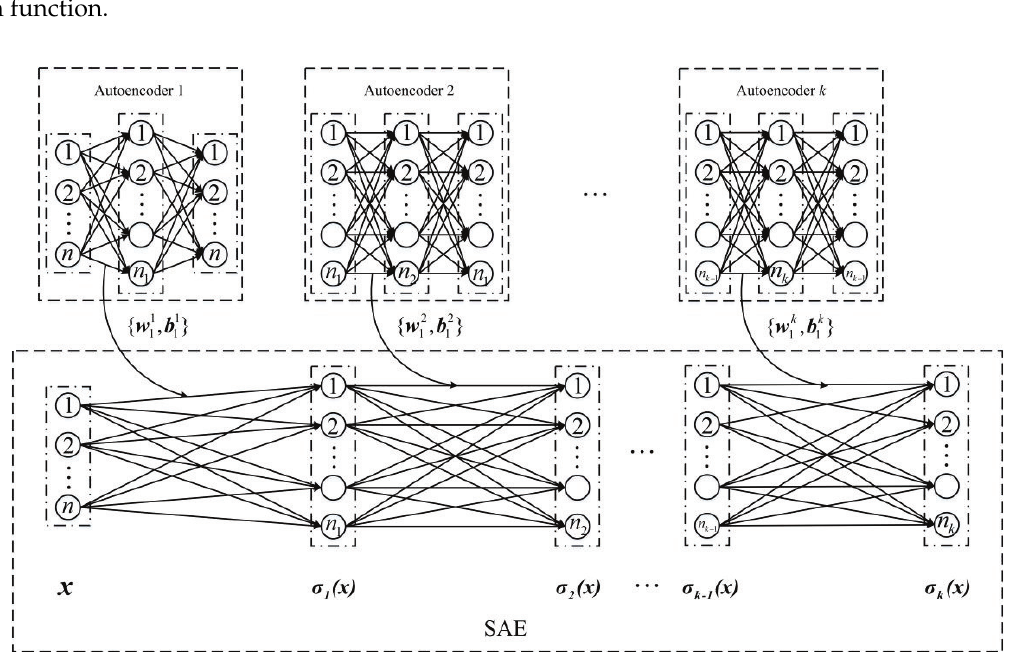
Figure 2. The stacked autoencoders with k hidden layers and its layerwise training